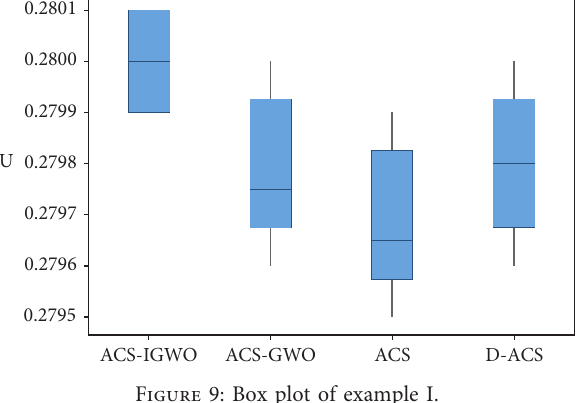
Figure 9: Box plot of example I.